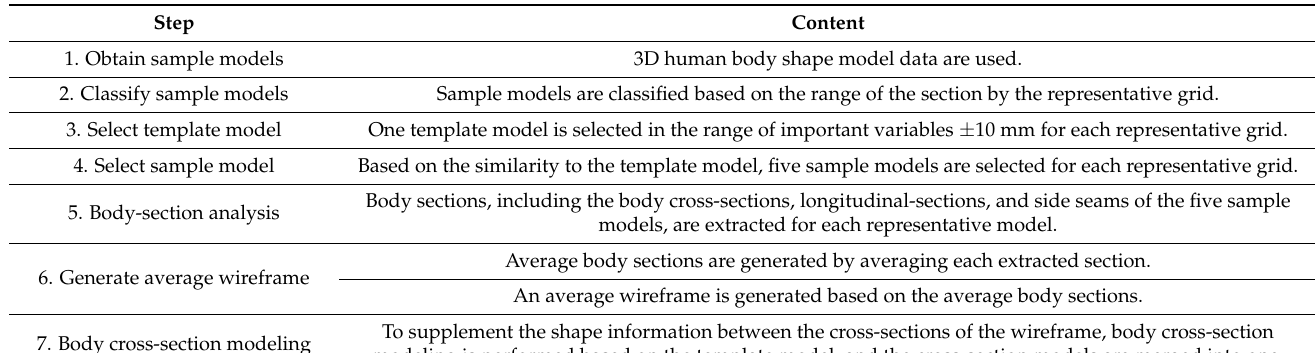
Table 3. Average model generation